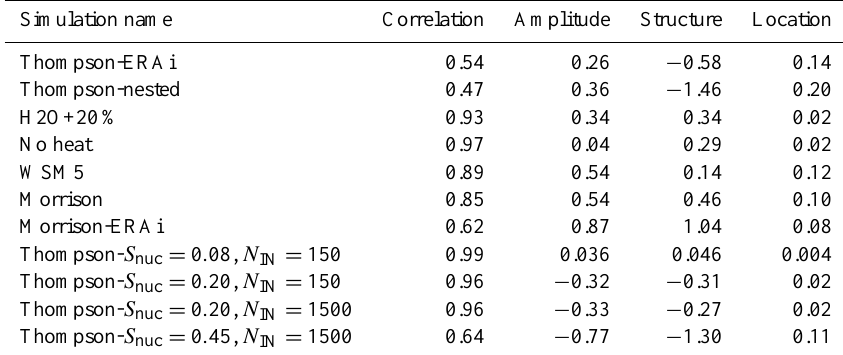
Table 5. Correlation and SAL (see text for details) for the ice water path above 14km in WRF simulations compared to the reference simulation at 12:00 on 28 January 2009. The “cloud threshold” for SAL was chosen to be a fourth of the maximum ice water path (see Wernli et al.,